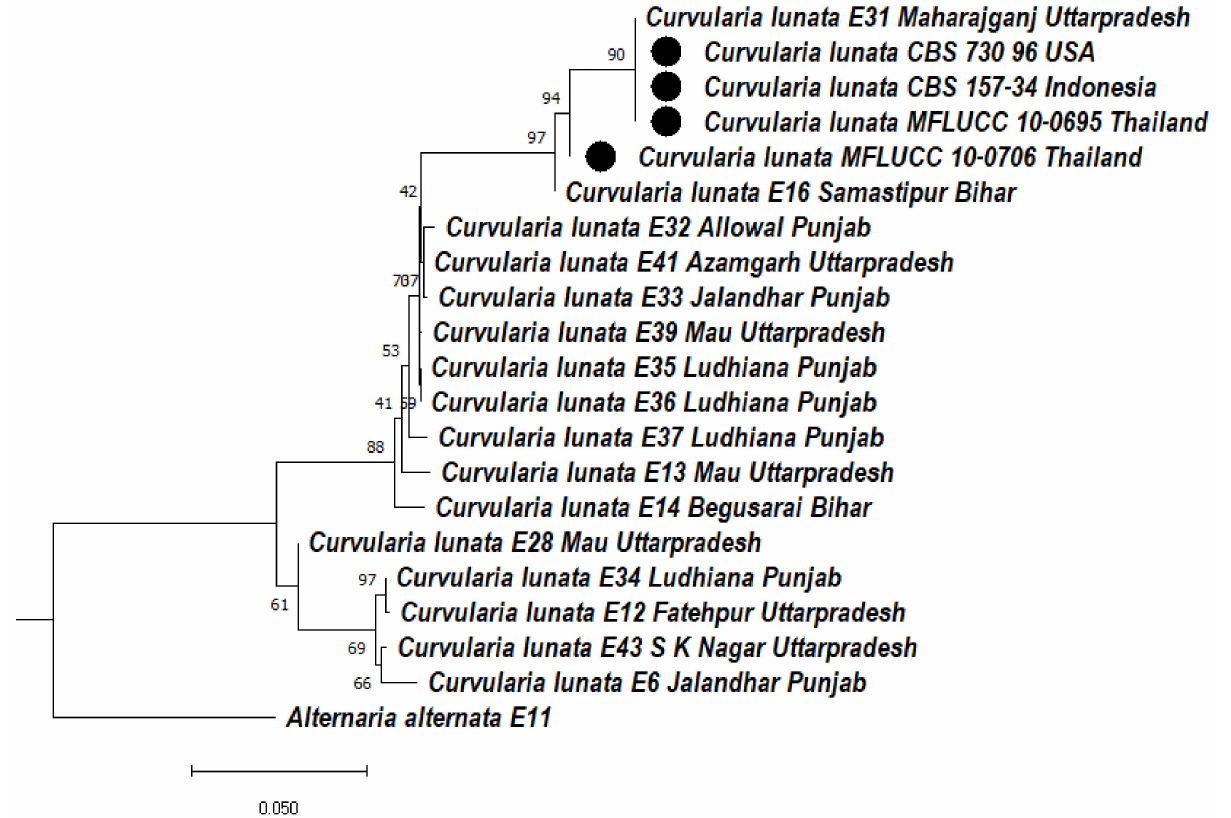
Figure 7. Dendrogram constructed from maximum likelihood method based on combined internal transcribed spacer (ITS) and large subunit gene regions (LSU). Sequenced data of the Curvularia lunata isolates were inferred with Raxml based on GTR + Gamma model. Numerical value presented in the node indicates bootstrap value with a 1000 non-parametric bootstrap replicates analysis. The symbol • denotes as ‘ ex-type ’ closely related species sequences obtained from GenBank. Alternaria alternata used as an